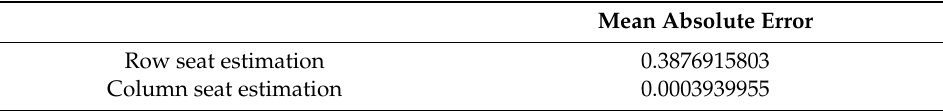
Table 1. Mean absolute error (MAE) of position estimation.